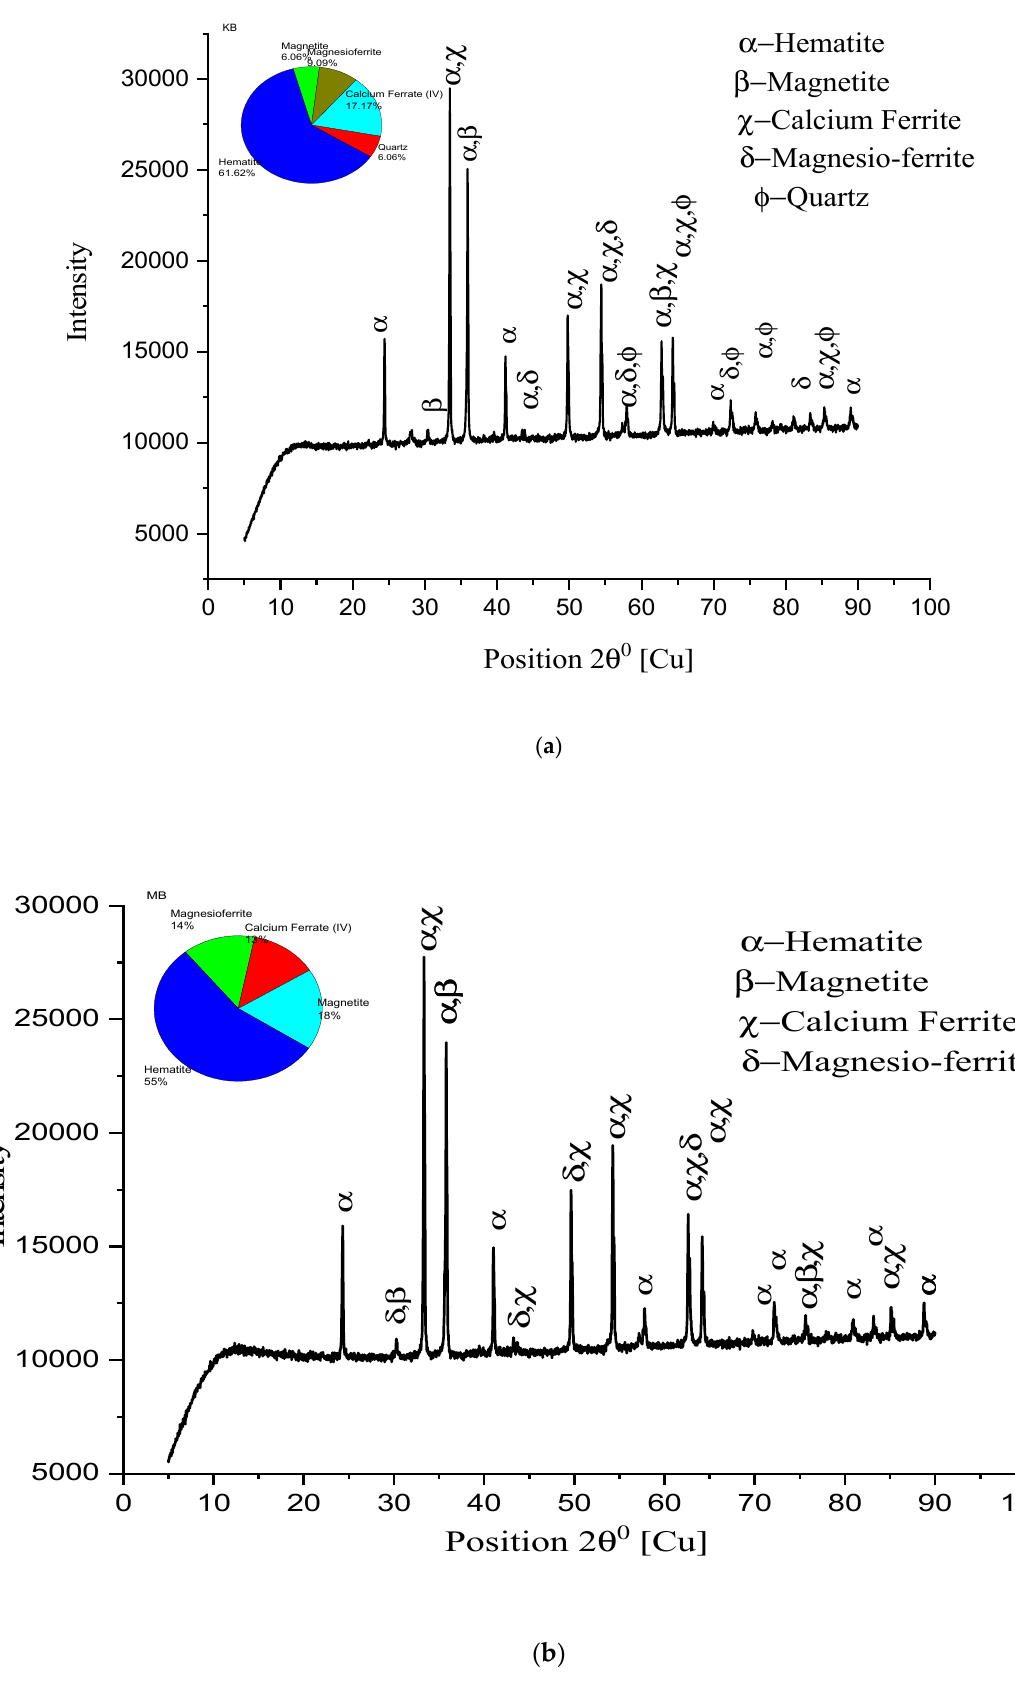
Figure 13. XRD patterns of pellet ( a ) K2B and ( b ) M2B.